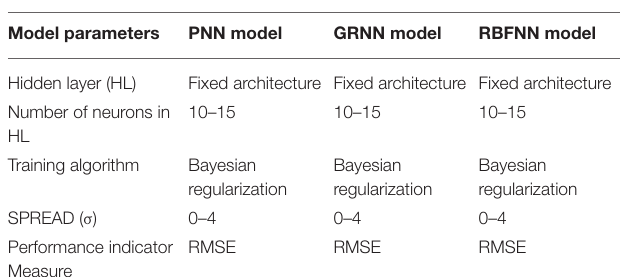
TABLE 1 | Model parameters